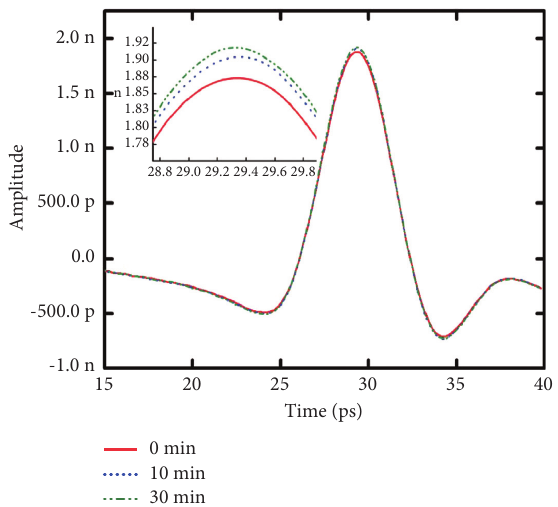
Figure 7: Time-domain spectra of the THz transmission intensity of the CMC-Na colloid located in an electric field for different times.